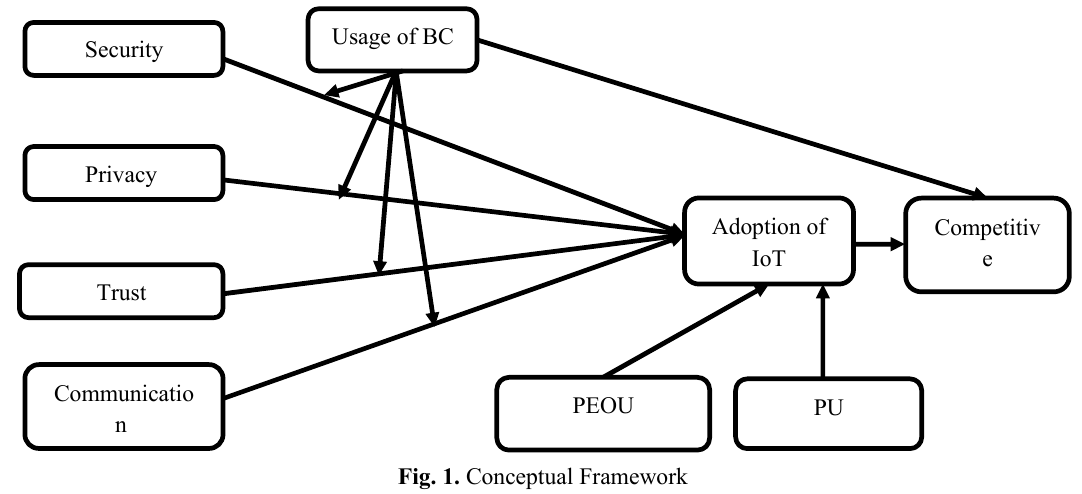
Fig. 1. Conceptual